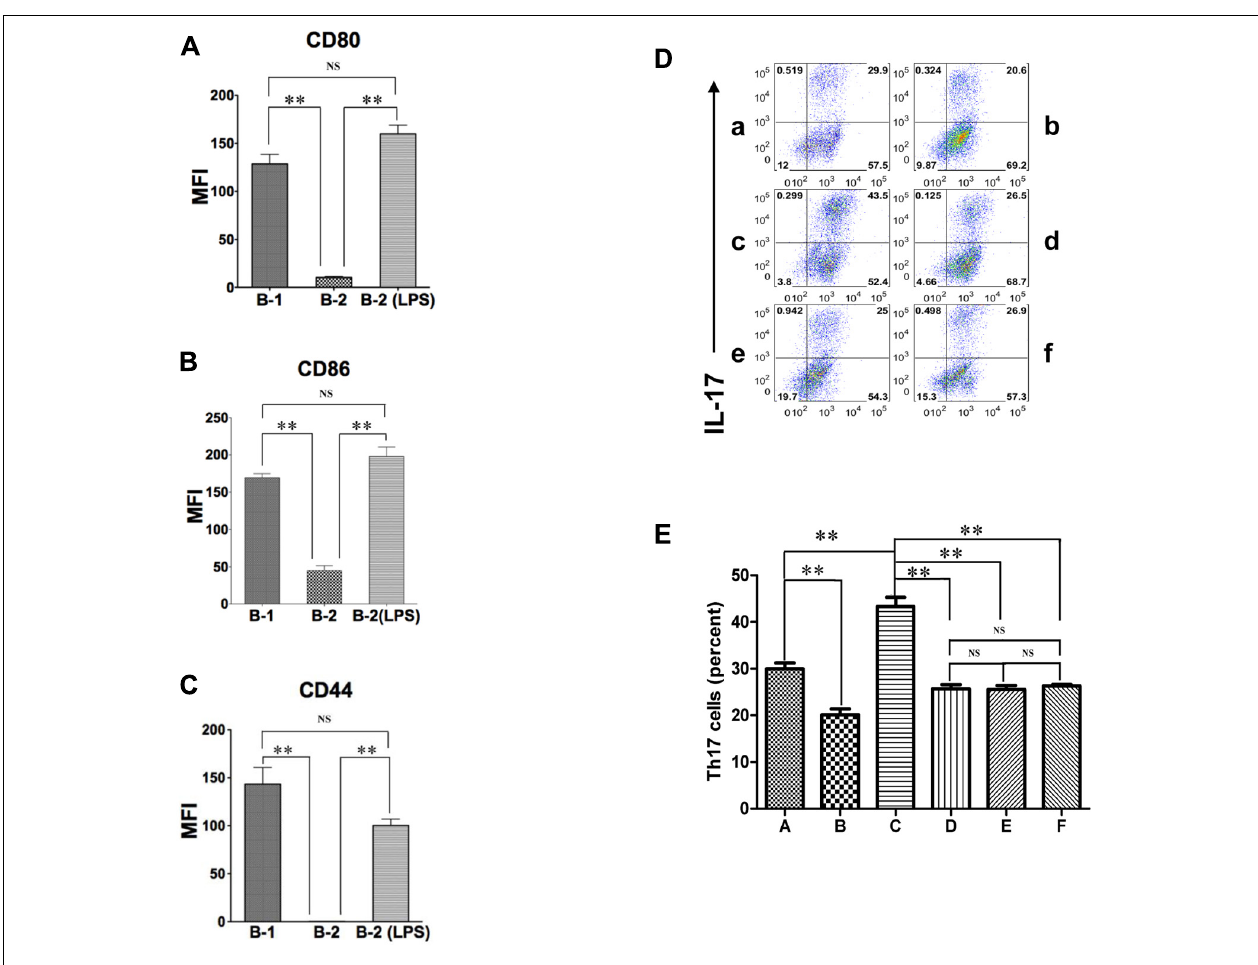
FIGURE 3 |Activated B-2 cells stimulateTh17 cell differentiation like B-1 cells. (A–C) Peritoneal B-1 cells and splenic B-2 cells were evaluated for expression of CD80 (A) , CD86 (B) , and CD44 (C) by immunofluorescent staining and flow cytometry. Splenic B-2 cells were sort-purified and stimulated by 10 μ g/mL LPS and then similarly evaluated. Mean values are shown along with lines indicating SEMs ( n = 3). (D,E) Sort-purified BALB/c peritoneal B-1 cells (a,b) and splenic B-2 cells previously stimulated by 10 μ g/mL LPS (c–f) were co-cultured at a 1:2 ratio with magnetic bead